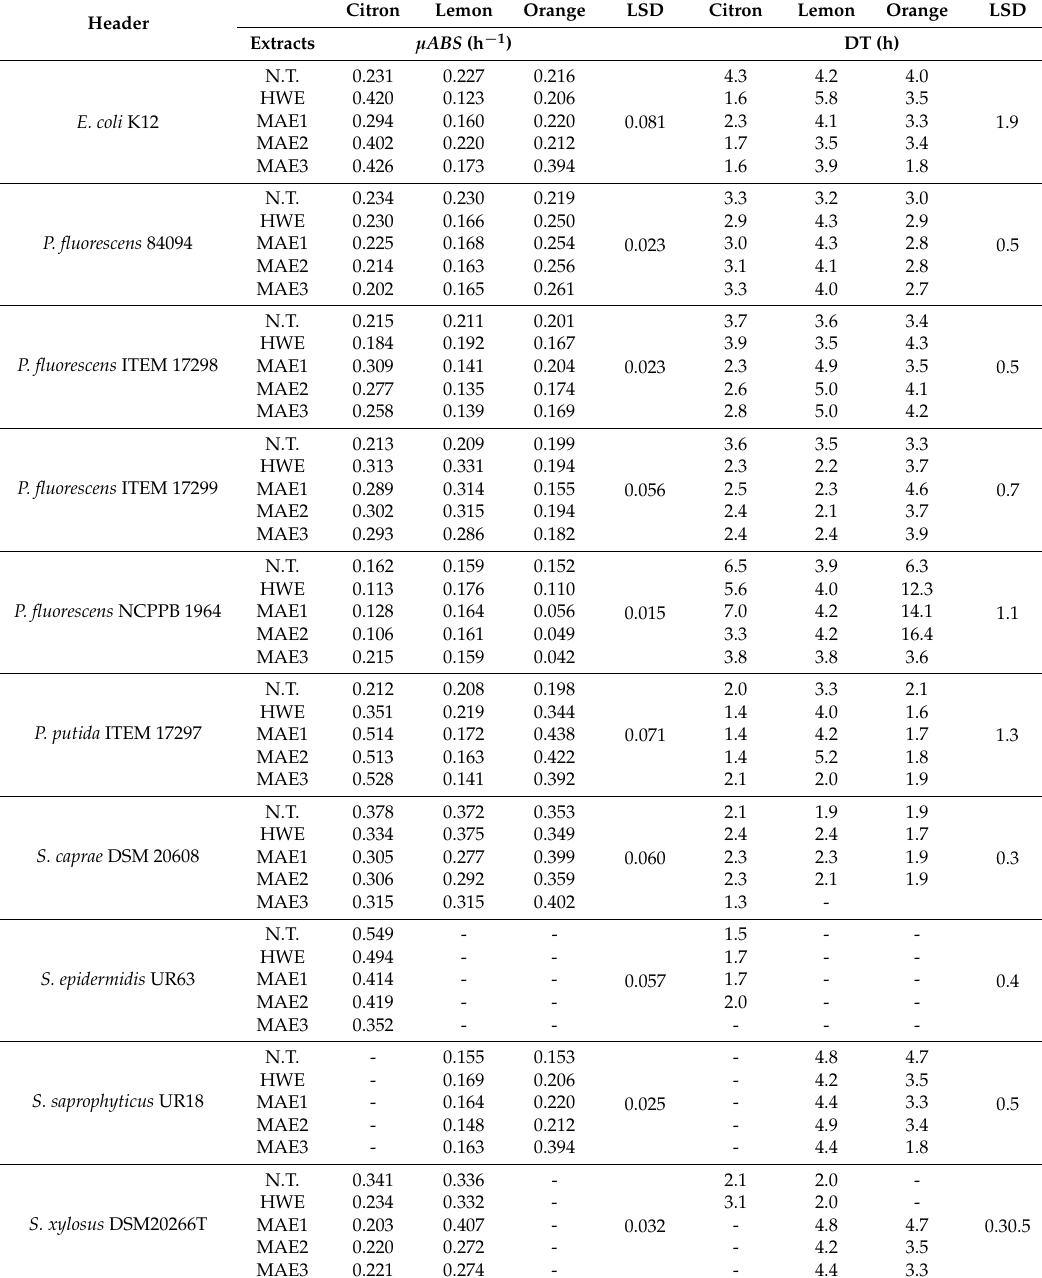
Table 3. Growth rates ( µ ABS ) and duplication time (DT) shown by bacterial cultures amended with different aqueous extracts of citron, lemon, and orange